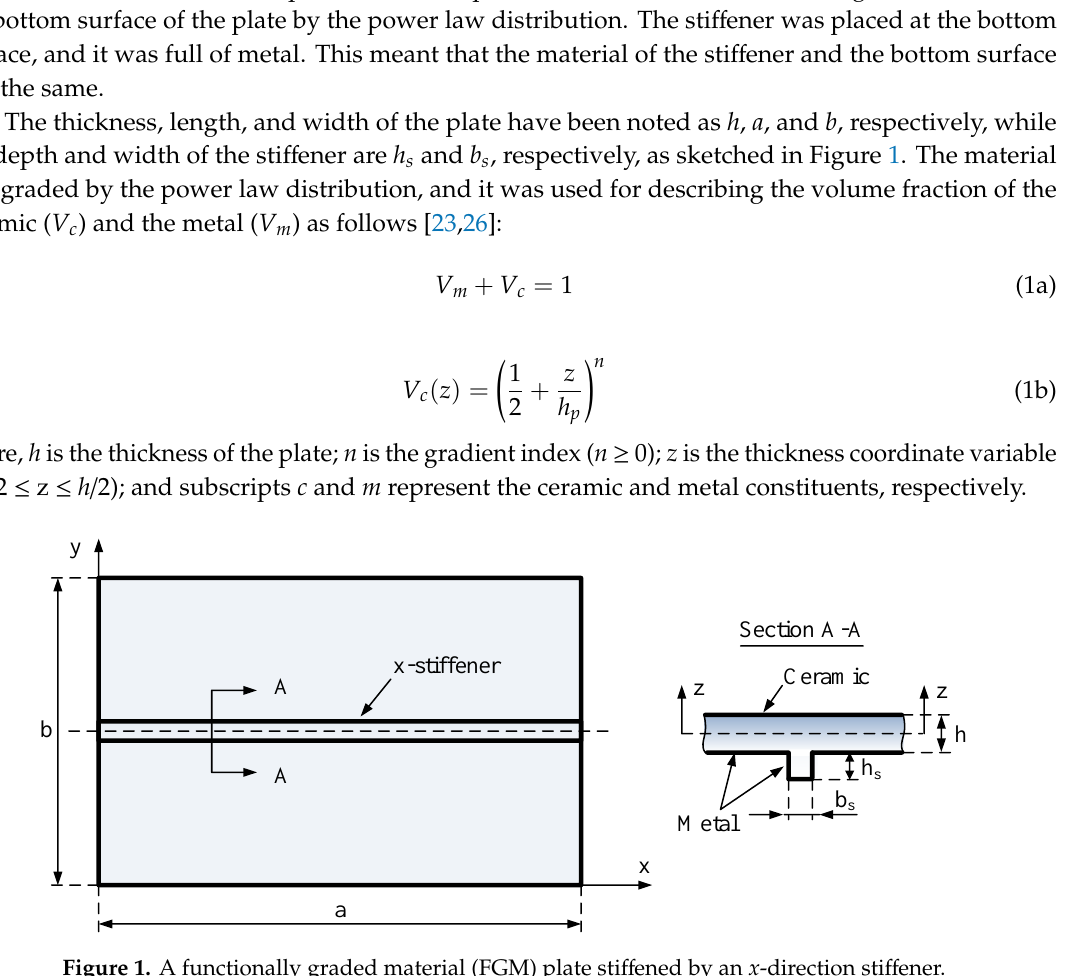
Figure 1. A functionally graded material (FGM) plate stiffened by an x- direction stiffener.